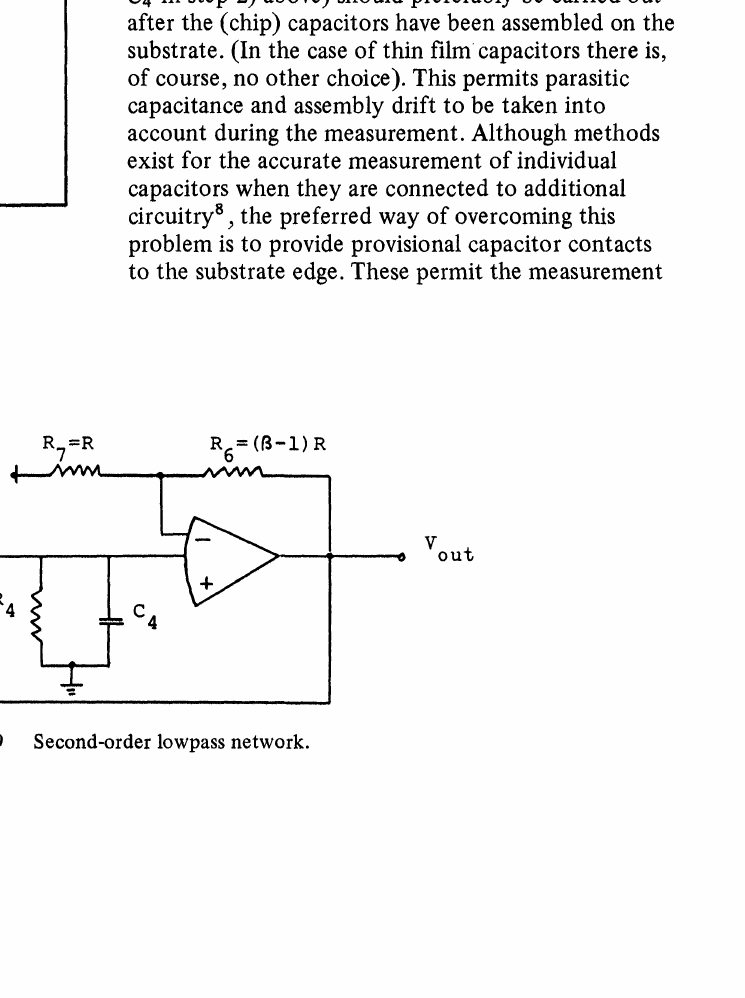
VALUES Deterministic tuning sequence.